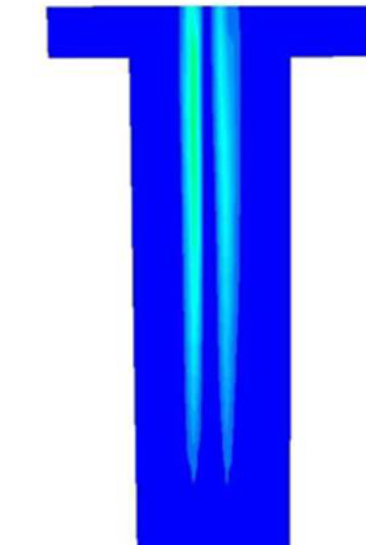
Figure 8. Surface temperature distribution in sub-channel square model.